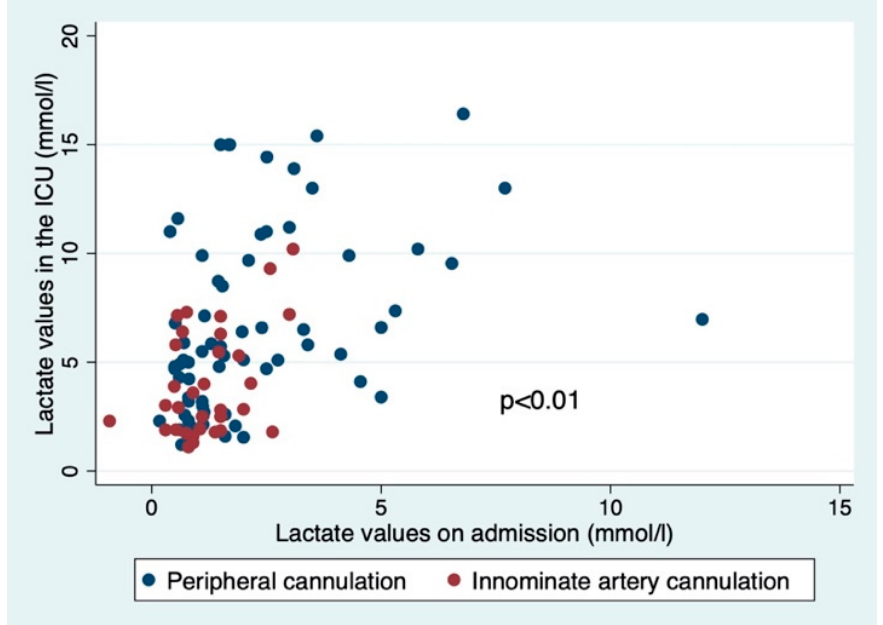
Figure 2. Scatterplot of lactate values in the ICU plotted against lactate values on admission.